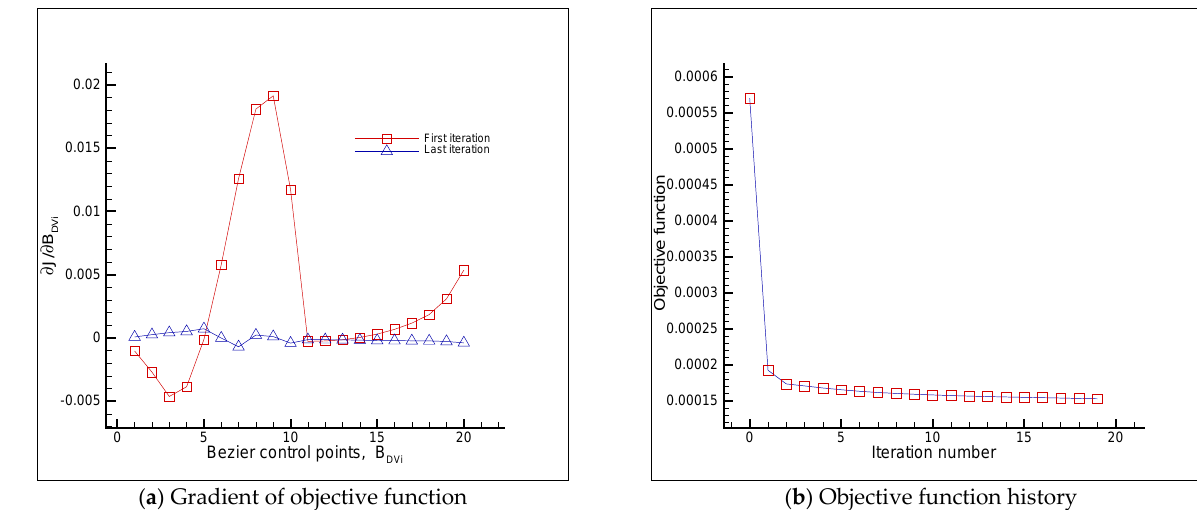
Figure 15. The gradient of the objective function with respect to the design variables ( a ) and the history of the objective function during the shape optimization process (Test case II).